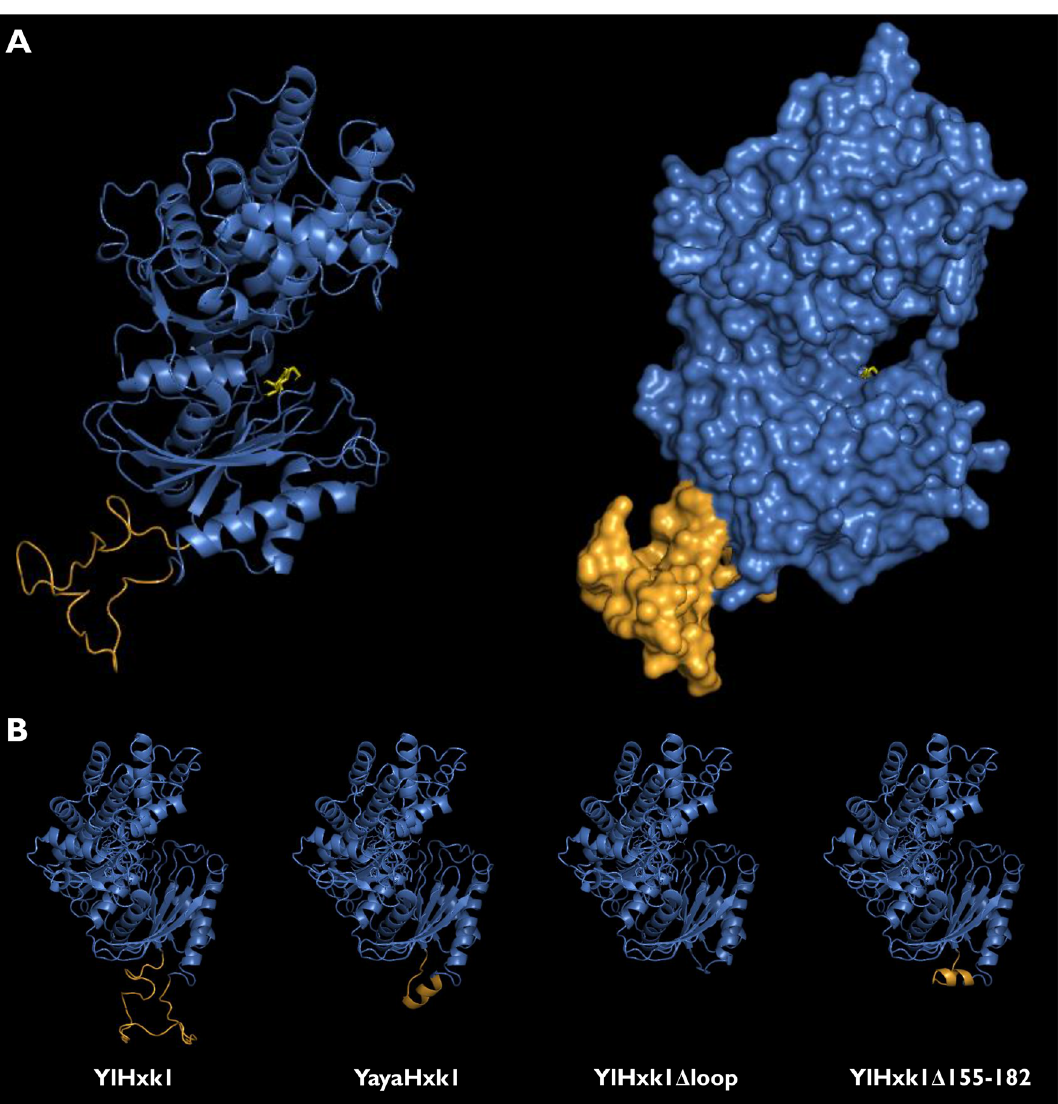
Figure 2. ( A ) Three-dimensional models of YlHxk1 (main structure in blue and the loop in orange) in complex with glucose (yellow); ( B ) comparison of YlHxk1, YayaHxk1 and modified YlHxk1